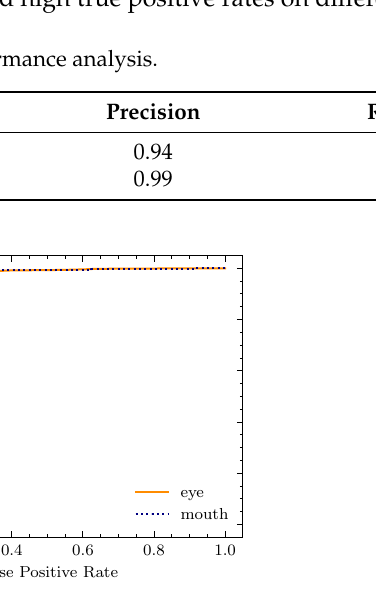
Figure 4. The ROC curve of our facial representation